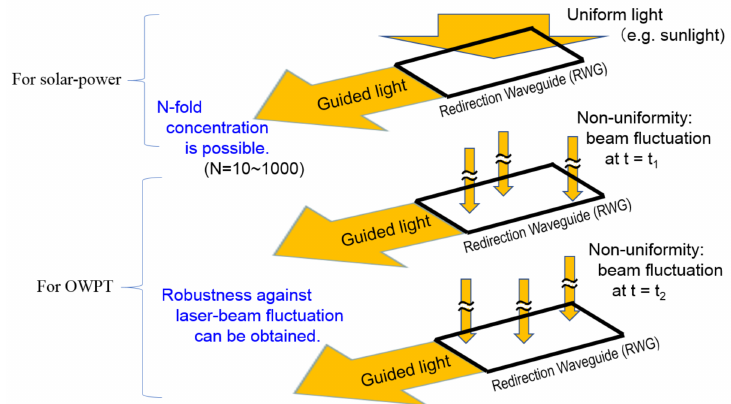
Figure 1. A system with 2D-connected photoreceptor-conversion scheme, which provides us with concentrator solar-cell systems (top figure) as well as an e ffi cient OWPT system that is robust against spatial beam fluctuations as illustrated in bottom two which give the same output at the